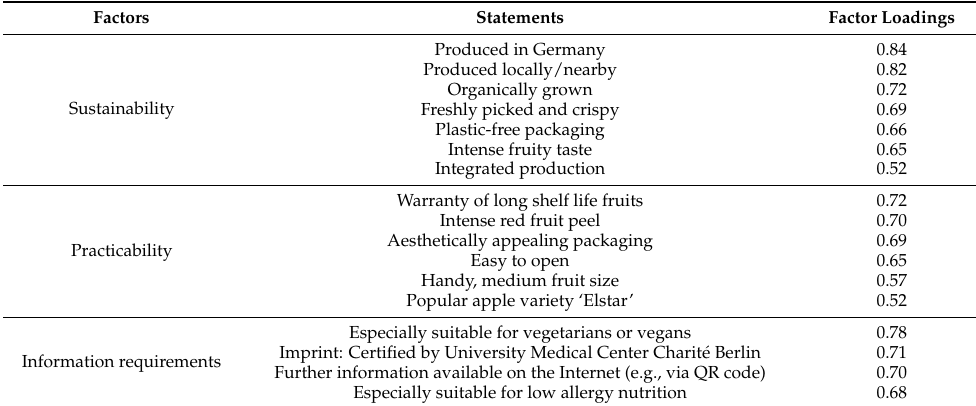
Table 5. Rotated component matrix of principal component analysis and allocation to factors.